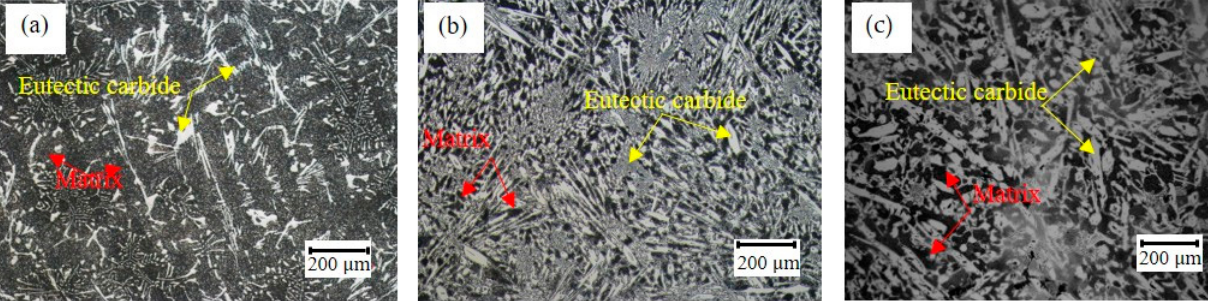
Figure 4. Optical micrograph of: ( a ). MWCI; ( b ). 18Cr MWCI as–QT; ( c ). 27Cr MWCI as–QT.